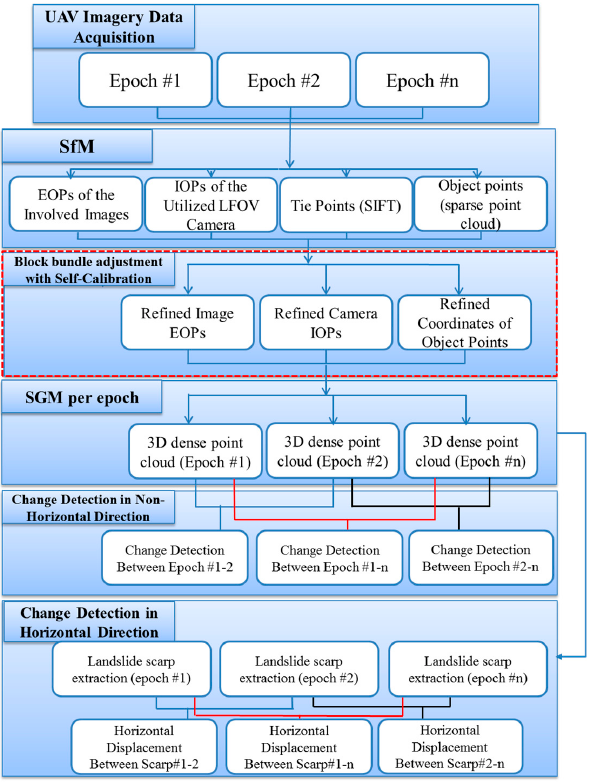
Figure 2. Overview of the workflow from the acquired unmanned aerial vehicle (UAV) image-based datasets to the change detection analysis. datasets to the change detection